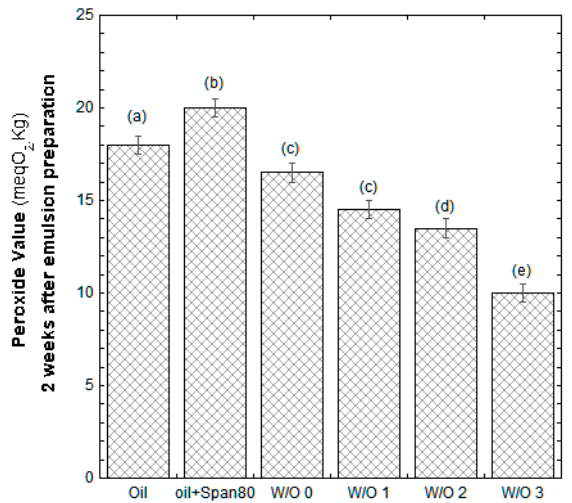
Figure 4. PV of the samples measured two weeks after their preparation. Data reported are the mean value of three replicates. Vertical bars represent the standard deviation. The same letters are not statistically different among treatments by the Tukey test ( p < 0.05).